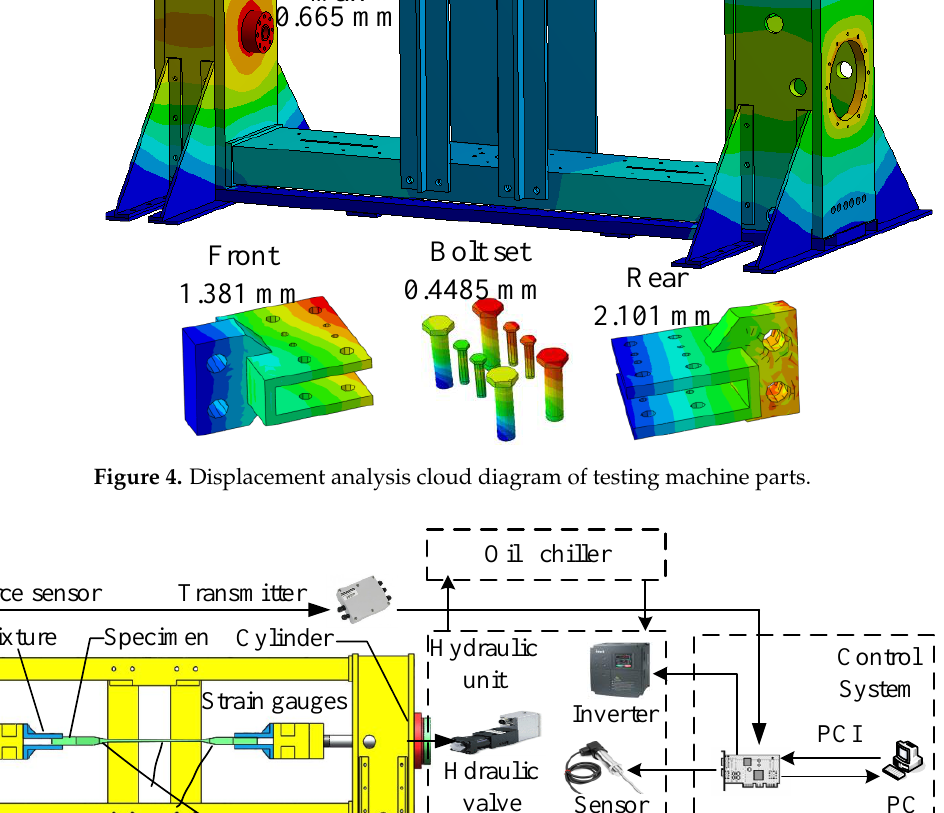
Figure 5. Experimental control scheme diagram.